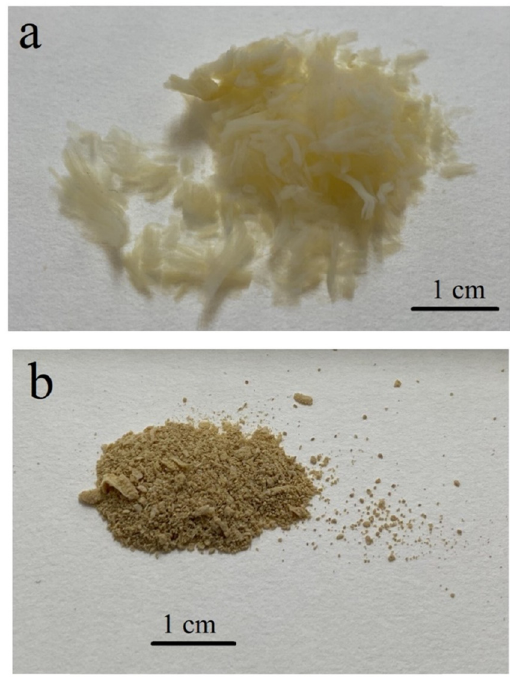
Figure 13: The photograph of the fumes collected from the chamber after gas re fi ning. ( a ) In vacuum condition and ( b ) chamber fi lled with Ar